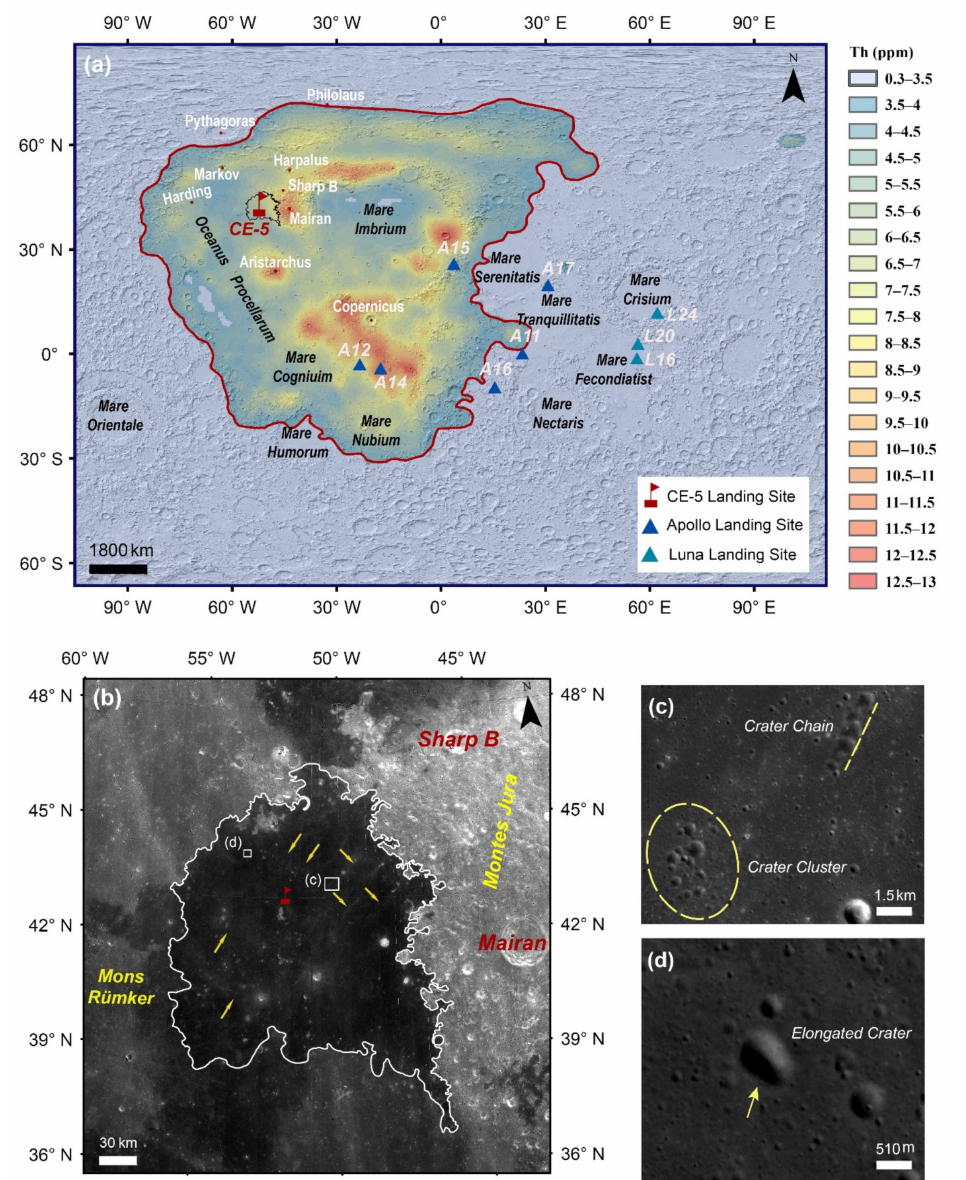
Figure 1. ( a ) Th content of Procellarum KREEP Terrane (PKT) in simple cylindrical projection (the red solid line is the boundary of PKT; the black solid line denotes geologic boundary of Em4 [8]; “A” represents the Apollo sampling sites and “L” represents the Luna sampling sites; the background image is the hillshade produced from SLDEM2015; Th data were observed from LP mission with the resolution of 5 ◦ /pixel [15]). ( b ) Kaguya MI 1550 nm band reflectance image covering the Em4 unit in Lambert conformal conic projection (the red flag marks the CE-5 landing site. The arrows denote the external ejecta patches from different directions). ( c , d ) show the secondaries in the areas marked by white boxes in ( b ). The secondaries in ( c ) are in cluster and chain patterns. ( d ) shows an elongated crater with the long and short axes of 850 m and 634 m, respectively. The elongated shape indicates a secondary impact